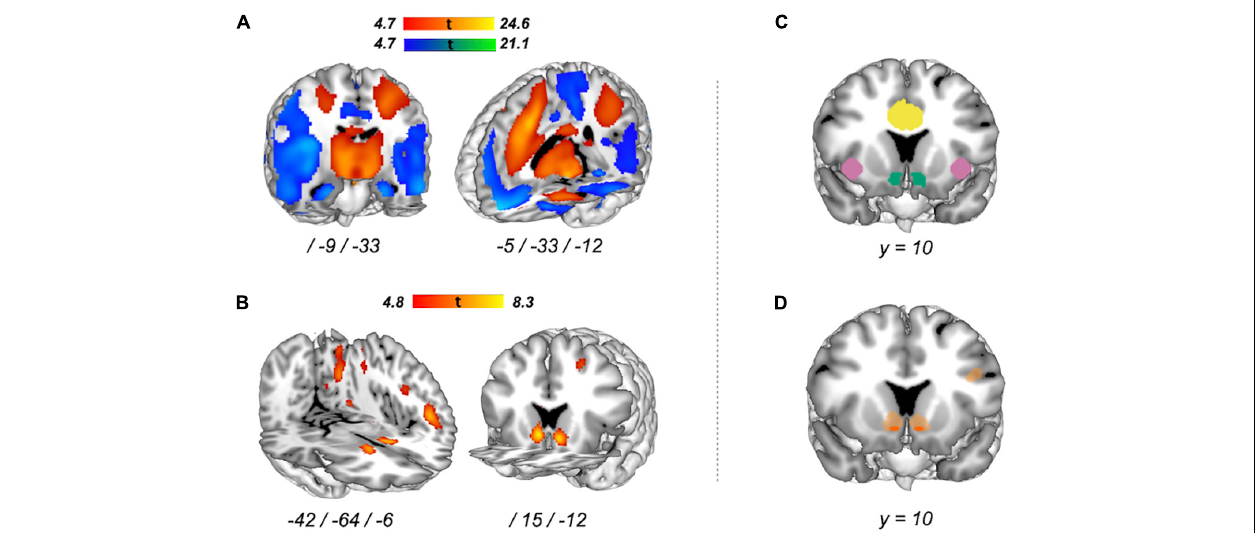
FIGURE 3 | Whole-brain voxel-wise group-level activation for risky versus safe decisions in two functional MRI (fMRI) tasks and their intersection. (A) Balloon Analog Risk Task (BART) brain activation [peak-level family-wise error (FWE), p < 0.05] for “Pumps reward versus Pumps control”. Red–yellow areas represent increased activation, blue–green areas represent decreased activation. (B) Monetary gambles brain activation (peak-level FWE, p < 0.05) for “Accept versus Reject”. Red areas represent increased activation (no significant reverse effect). (C) Regions of interest (ROIs). Colors correspond to the following ROIs: blueish green for NAcc, reddish purple for AIns, and yellow for ACC. (D) Intersection of increased activation associated with risky versus safe decisions in the BART (Pumps reward > Pumps control) and monetary gambles (Accept > Reject). Given our focus on risk matrix regions, in dark orange, we show intersecting increased activation for regions of interest only (small volume correction, peak-level FWE, p < 0.05). Shown in light orange are neural regions with intersecting increased activation at the level of the whole brain (peak-level FWE correction, p <